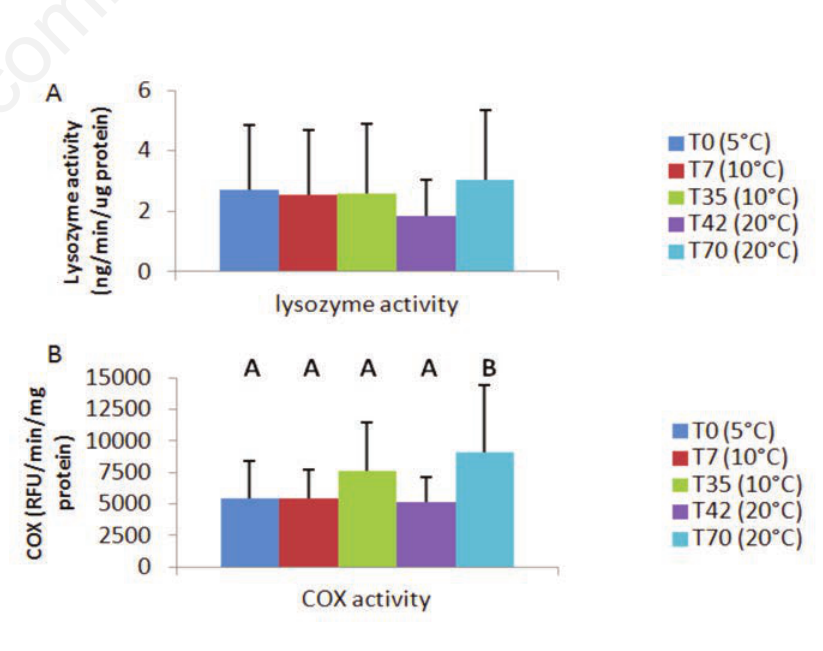
Figure 5. A) Lysozyme activity in cell-free hemolymph; B) and cyclooxygenase (COX) activity on hemocytes of Mytilus edulis exposed to different temperatures (n=30/experi- mental phase,